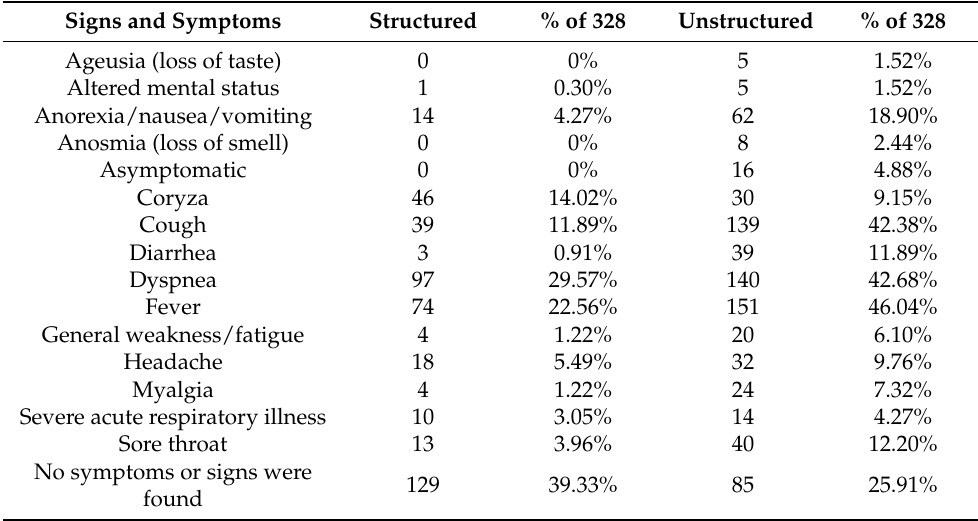
Table A3. Signs and Symptoms in Both Structured and Unstructured